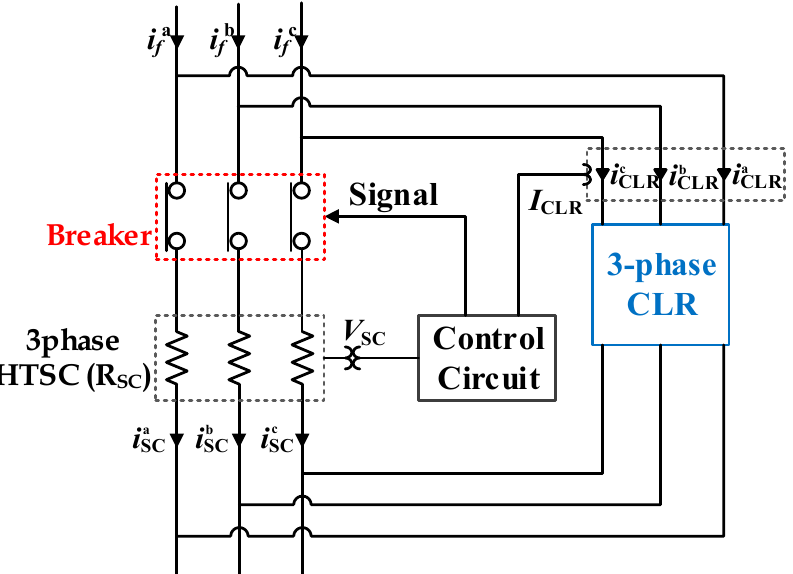
Figure 2. Configuration of trigger type SFCL. Table 2. Parameters of trigger type SFCL.